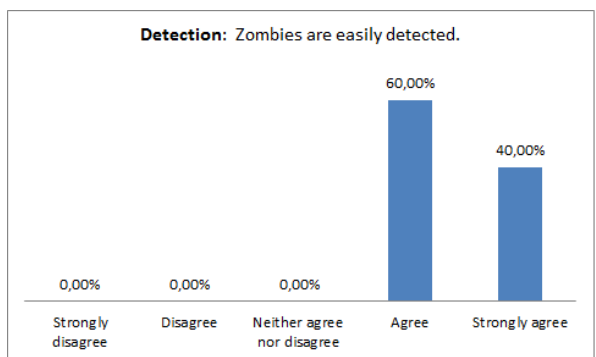
Figure 16: Zombie